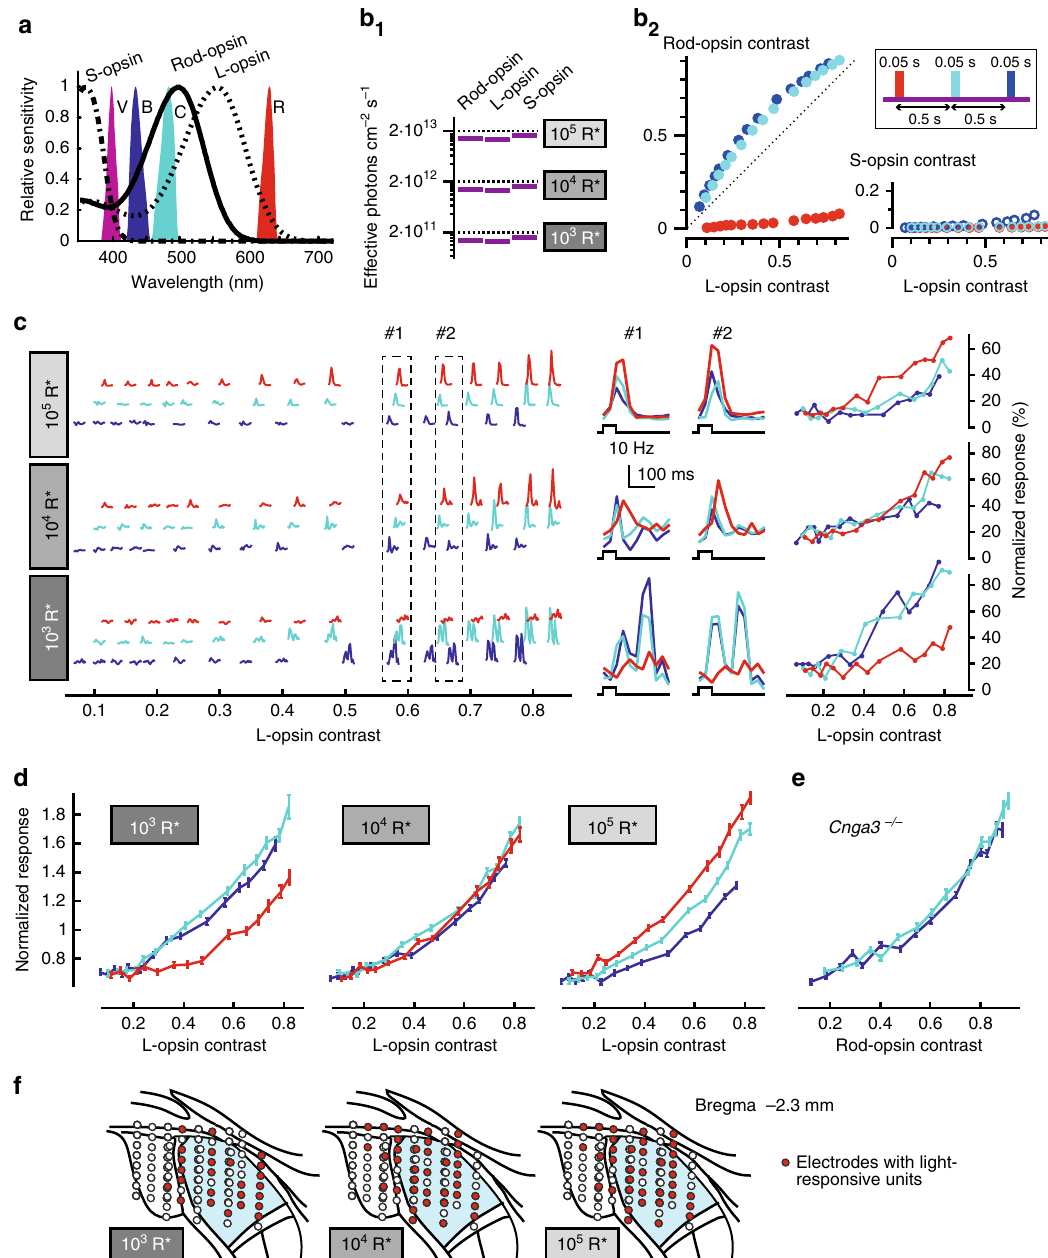
Fig. 6 Photopic LGN activity in vivo is in fl uenced by rods in the presence of cones. a Spectral power of stimuli and photoreceptor spectral sensitivity in Opnmw R ;Opn4 − / − mice. S-opsin, rod-opsin, and L-opsin are roughly equally sensitive to the violet (V) background, but have markedly different sensitivity to blue (B), cyan (C), and red (R) fl ash stimuli. b Stimulus intensity and contrast. b 1 Estimated absolute intensity of the violet background (retinal irradiance). Dashed lines correspond to 10 3 , 10 4 , and 10 5 R*rod − 1 s − 1 . b 2 Michelson contrast of blue, cyan, and red fl ash stimuli. They present similar contrast for L-opsin, while rods are hardly activated by red stimuli. All stimuli present very weak contrast to S-opsin. Inset: timing of stimulus fl ashes. c Responses of an example unit at different irradiances. Left: mean fi ring rate for stimuli of all presented contrasts. Middle: expanded comparison of responses to blue, cyan, and red stimuli of roughly equivalent L-opsin contrast. Right: normalized mean response amplitude (Methods) as function of L-opsin contrast. d Mean ± s.e.m. of response amplitude, normalized by the mean response across contrasts and colors (Methods), to blue, cyan, and red fl ashes as a function of L-opsin contrast for all light-responsive units at different irradiances. Responses at the three wavelengths could be fi t with a single function at 10 4 R* rod − 1 s − 1 (consistent with the view that they are driven by L-opsin), but not at lower or higher irradiances (see Supplementary Table 1 for statistical analysis of curve fi ts). e Mean ± s.e. m. of normalized response amplitude (Methods) for cyan and blue fl ashes presented to Cnga3 − / − mice at 10 2 R*rod − 1 s − 1 as a function of estimated rod contrast ( n = 229 responsive units from three mice; two different electrode placements in mice 1 and 2, three placements in mouse 3). The responses at the two colors were indistinguishable con fi rming the suitability of our methods for estimating photoreceptor spectral sensitivity in vivo (BC: R 2 BC = 0.448, R 2 BC,null = 0.448, Δ R 2 ≈ 0). f Histological con fi rmation for electrode placements in n = 3 Opnmw R :Opn4 − / − BC